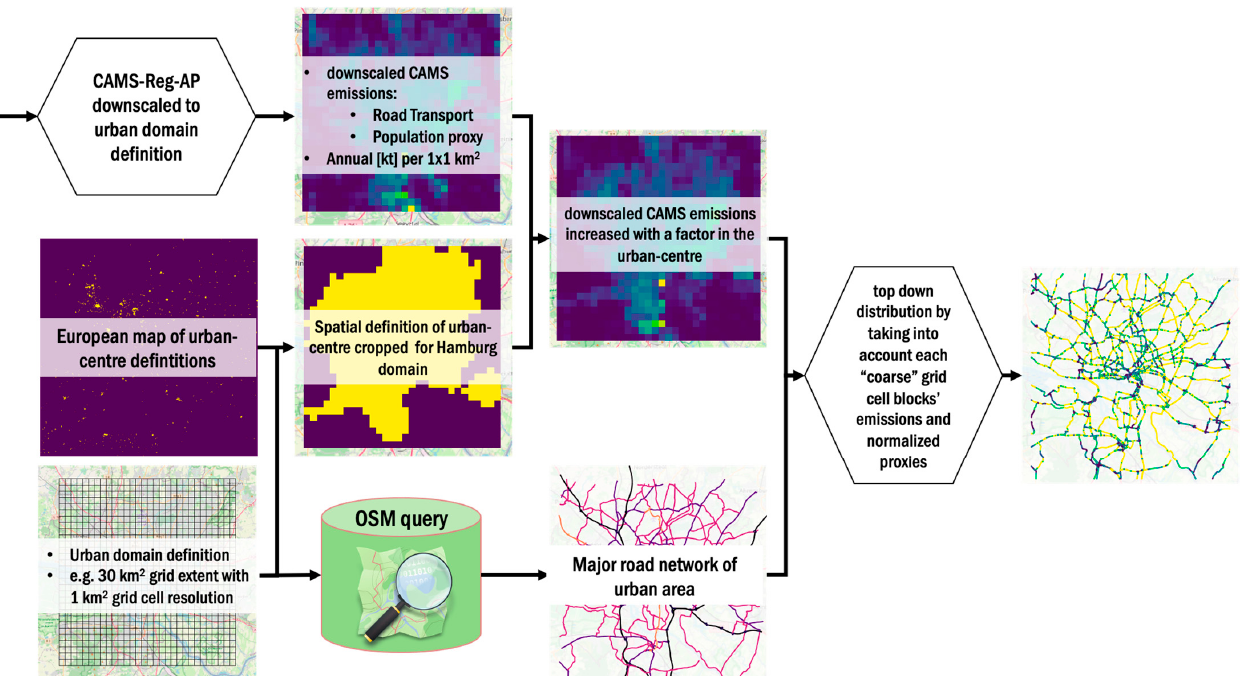
Figure 4. Line emissions downscaling procedure in the UrbEm approach.